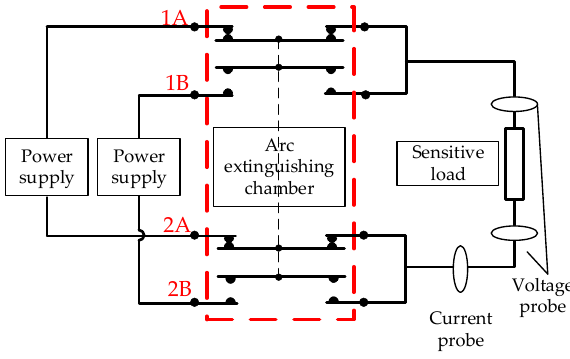
Figure 1. Circuit topology of dual power supply switching.